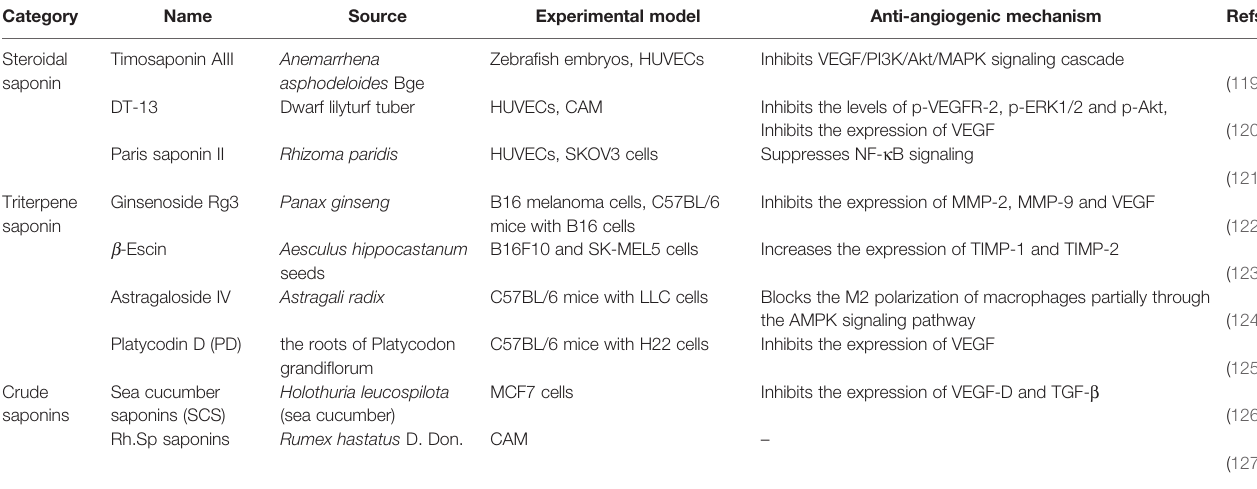
TABLE 6 | Natural anti-tumor angiogenesis saponins and their sources, experimental models and anti-angiogenic mechanisms.